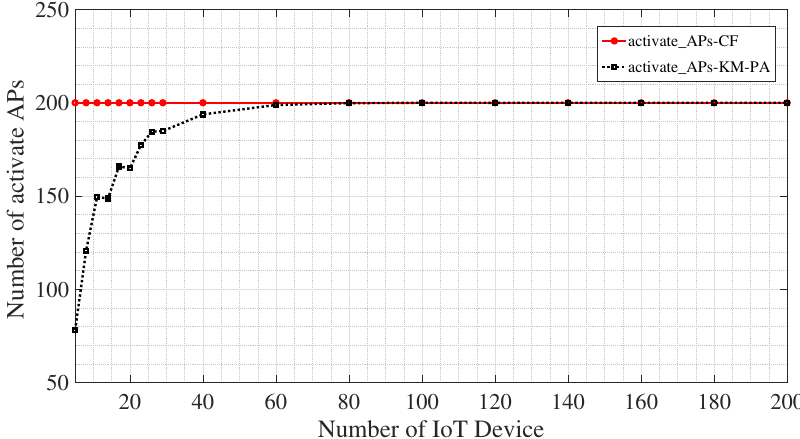
Figure 8. The number of IoTDs versus the number of activated